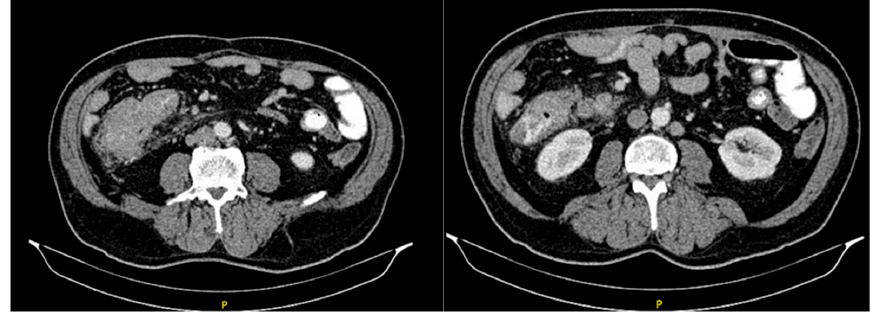
Figure 2. Abdominal CT scan showing tumor mass.